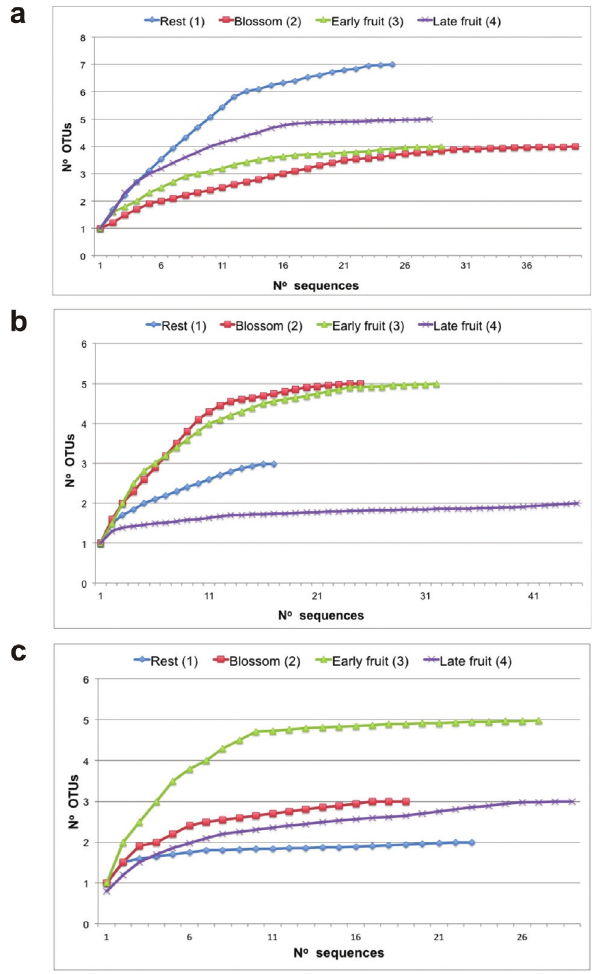
Figure 1 - Rarefaction curve for the 16S rDNA clone libraries constructed at each time point. An OTU is defined by having 97% similarity. a) C. arabica ‘Catuaí’, b) C. arabica ‘Obatã’, and c) C. canephora . Periods of harvest are depicted on the top of the figure: sample 1 – ‘rest’, sample 2 – ‘blossom’, sample 3 – ‘early fruit’, sample 4 – ‘late